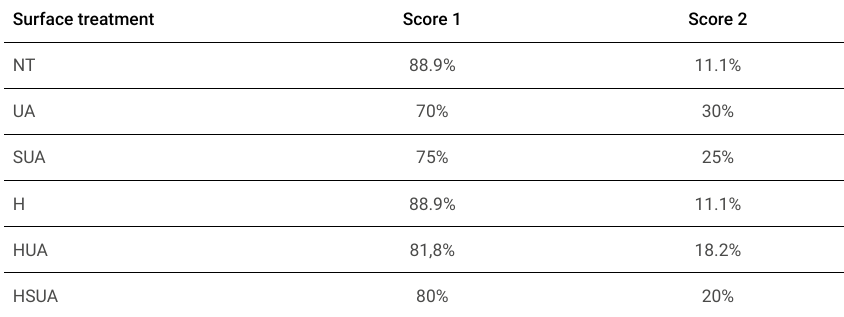
Table 2. Post surface analysis after pull-out